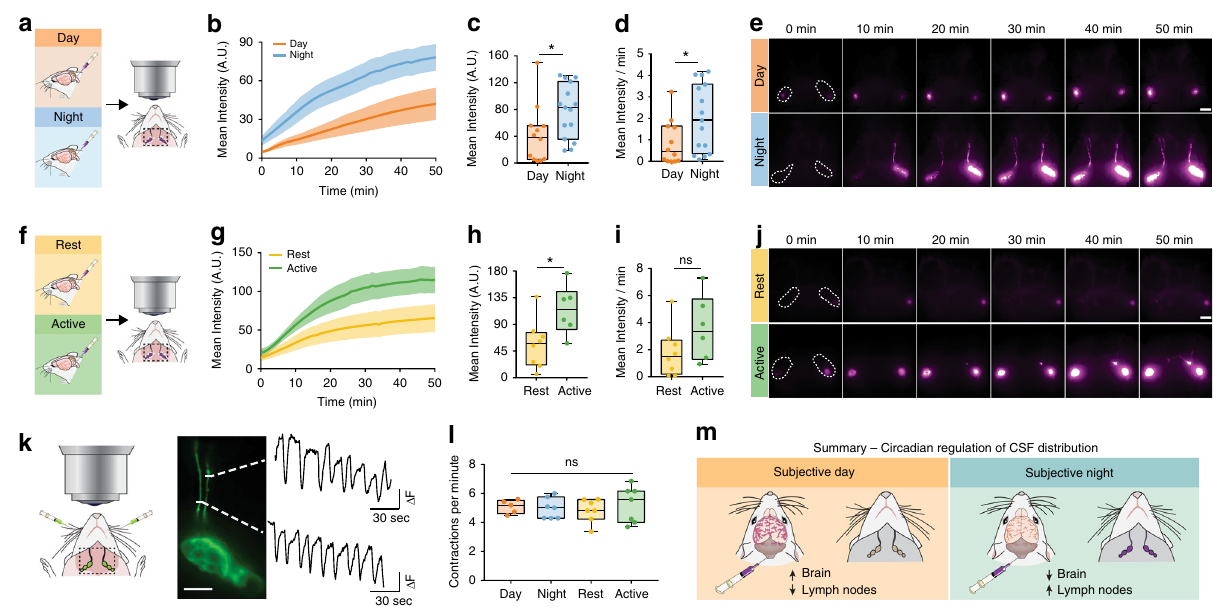
Fig. 5 Lymph node drainage exhibits circadian variation. a Experimental outline. Lymph nodes in purple, black dashed square: area imaged. White dashed lines: regions of interest (ROI) around lymph nodes. b Mean intensity (arbitrary units, A.U.) of lymph node fl uorescence during day (orange, for b – e : n = 12 mice) and night (blue, for b – e : n = 15 mice). Time 0 on all graphs indicate start of imaging, on average 8 min after tracer infusion start. Thick line: mean, shading: SEM. c Boxplot of lymph node intensity at minute 50. Two-sided t test, p = 0.0335. d Boxplot of the rate of lymph node fi lling calculated from the fi rst 20 min recording. Mann – Whitney test, p = 0.0321. e Representative images from in vivo lymph node imaging across 50 min for day (orange) and night (blue). White scale bar: 2 mm. f Experimental outline. g Average fl uorescence over time (thick line: mean, SEM: shading). h Boxplot of fl uorescence in lymph nodes at 50 min, during active (green, for f – j : n = 6 mice) and rest (yellow, for f – j n = 8 mice) phases. Two-sided t test, p = 0.0231. i Boxplot of rate of lymph node fi lling. j Representative time lapse images for animals housed in constant light for 10 days. White scale bar: 2 mm. k Diagram of experiment for lymph node contraction rate after FITC-dextran cheek injection, black dashed square: imaging area (left) with representative lymph vessel and trace of contractions from two regions of interest over 2 min (right). White scale bar: 1 mm. White dotted lines: area of measurement for traces. l Boxplot of contractions per minute of lymph vessels during the day ( n = 5 mice) and night ( n = 7 mice) in LD, and active ( n = 7 animals) and rest ( n = 7 animals) after 10 days in constant light. m Summary diagram of circadian regulation of CSF distribution. All boxplots minima: minimum value, maxima: maximum value, center: median, box and whiskers: quartiles, individual animals: colored dots. Asterisk indicates p < 0.05; ns: not signi fi cant. Source data are provided as a Source Data fi